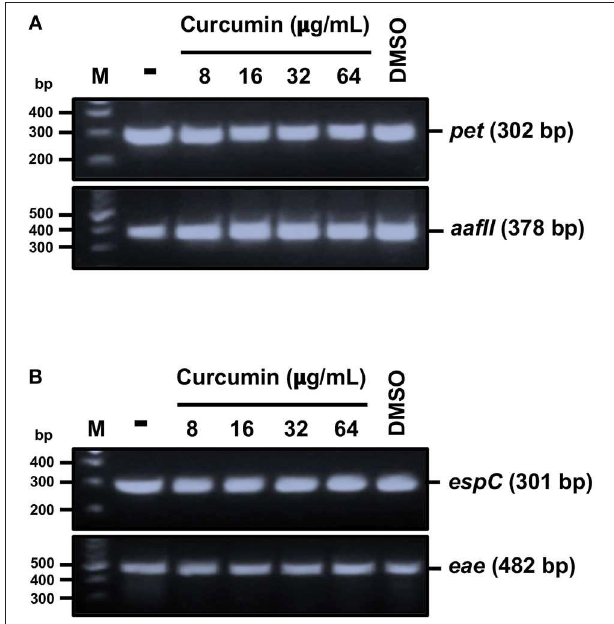
FIGURE 3 | Curcumin does not alter both pet and espC gene expression. Total RNA was isolated from bacteria (EAEC or EPEC) in the presence or absence of curcumin, as described in Figure 2 . RT-PCR assay and amplicons were analyzed by agarose gel electrophoresis (described in section Materials and Methods). Analysis of gene expression of pet and aafII from EAEC (A) ; espC and eae from EPEC (B) . As controls, bacteria without curcumin or vehicle only (DMSO) were